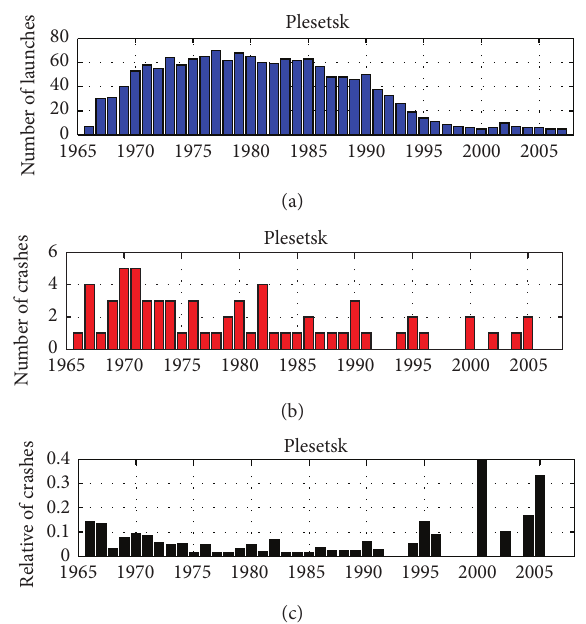
Figure 13: The yearly mean number of launches, crashes, and relativenumberofcrashes(uppertolowerpanel)atthehigh-latitude space port Plesetsk from 1966 till